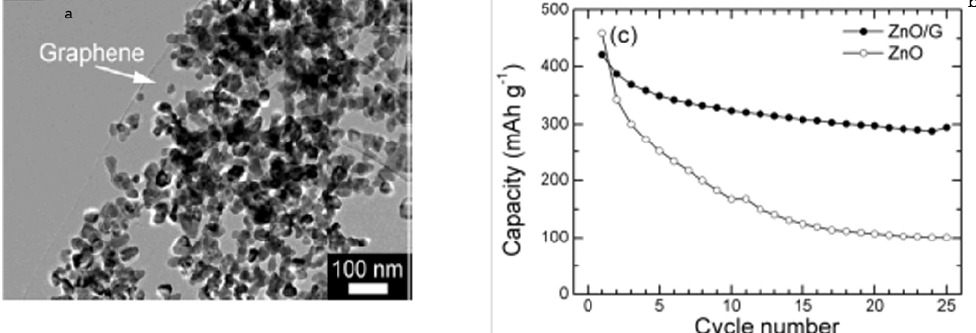
Fig. 7. (a) TEM image of ZnO/G and (b) comparison of cycling stability between bare ZnO and ZnO/G at 50 mA g -1 , reprinted with permission (open access) of Ref [58], Copyright 2012